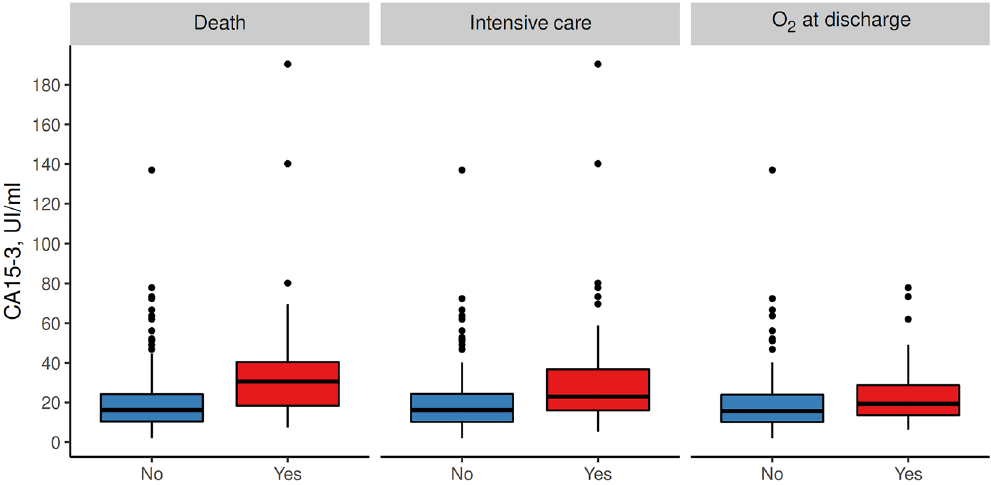
Figure 1. Distribution of CA 15-3 based on adverse events.